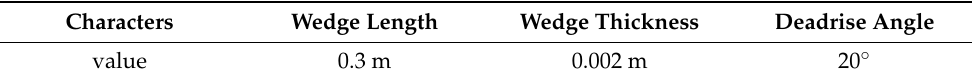
Table 7. Wedge characteristic used for one-way coupling verification solution.